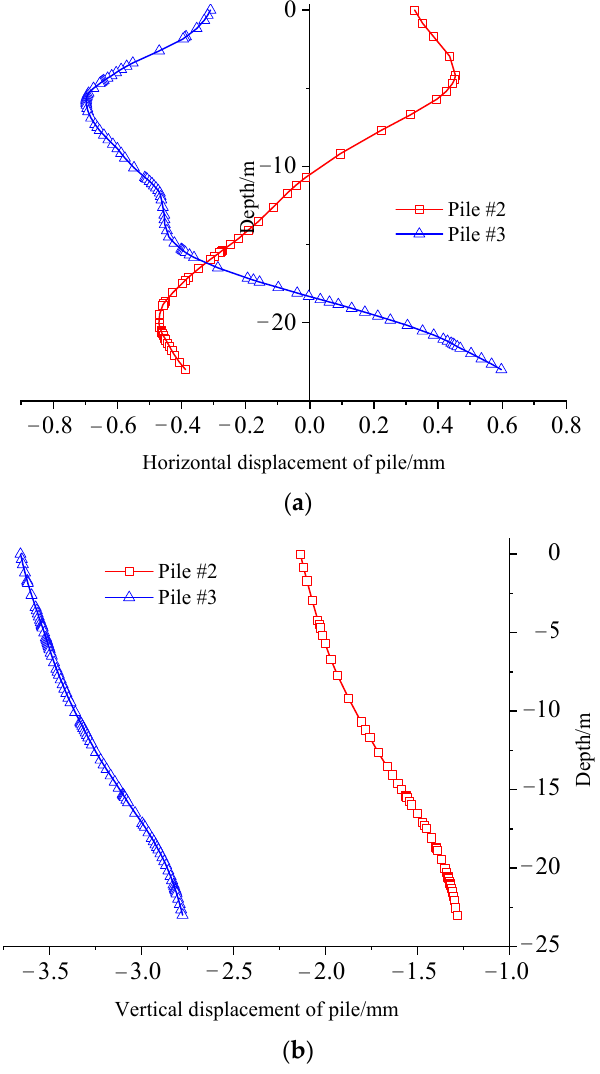
Figure 9. Deformation of piles #2 and #3. ( a ) Horizontal displacement. ( b ) Vertical displacement. Due to the grouting reinforcement treatment of the soil around the pile body, the stiffness of the surrounding soil layer is improved so that the surface settlement and the horizontal and vertical displacement of the pile can meet the deformation control standard. In the process of side crossing bridge pile excavation of the shield tunnel, the shield tunnelling attitude is controlled, and the tunnel face pressure is controlled to achieve continuous, balanced and stable construction. At the same time, synchronous grouting and grouting behind the wall is strengthened to avoid significant disturbance to the stratum, and the assembly quality of segments is strictly